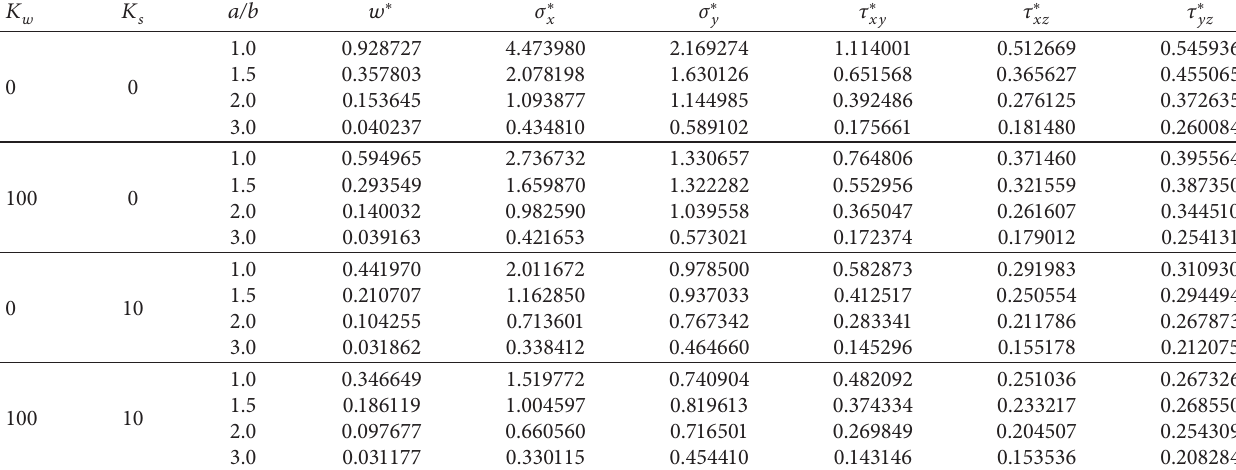
Table 6: The effects of aspect ratio a/b on the deflection and stresses of the